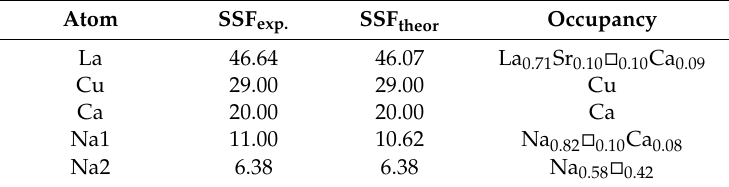
Table 3. Observed (exp.) and theoretical (theor.) site-scattering factors (SSF, e − ) and assigned occupancies for selected atom sites in the crystal structure of paratooite-(La).